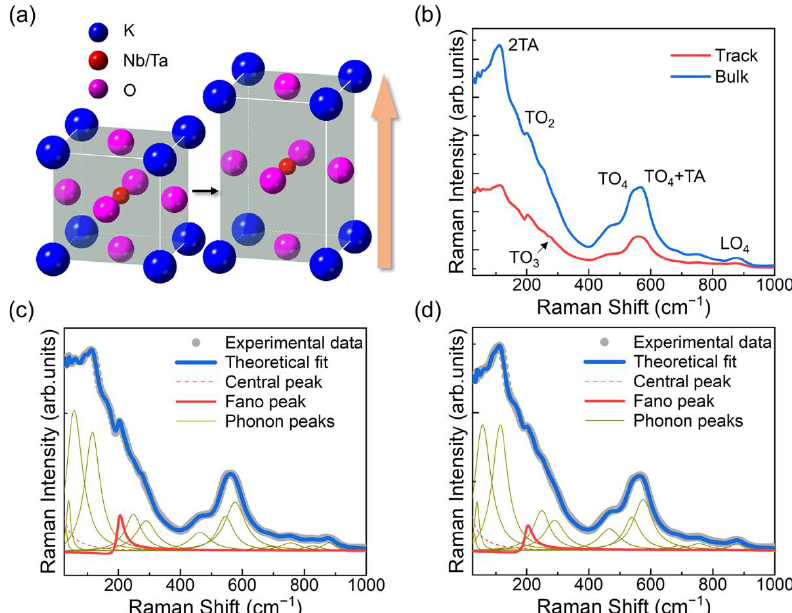
Figure 2. ( a ) The sketch diagram of the lattice deformation during the femtosecond laser processing. ( b ) The Raman scattering spectra of the femtosecond laser induced track (red line, and the bulk material (blue line), respectively. ( c ) Corresponding fitting curves of the track, and ( d ) the bulk material, respectively.